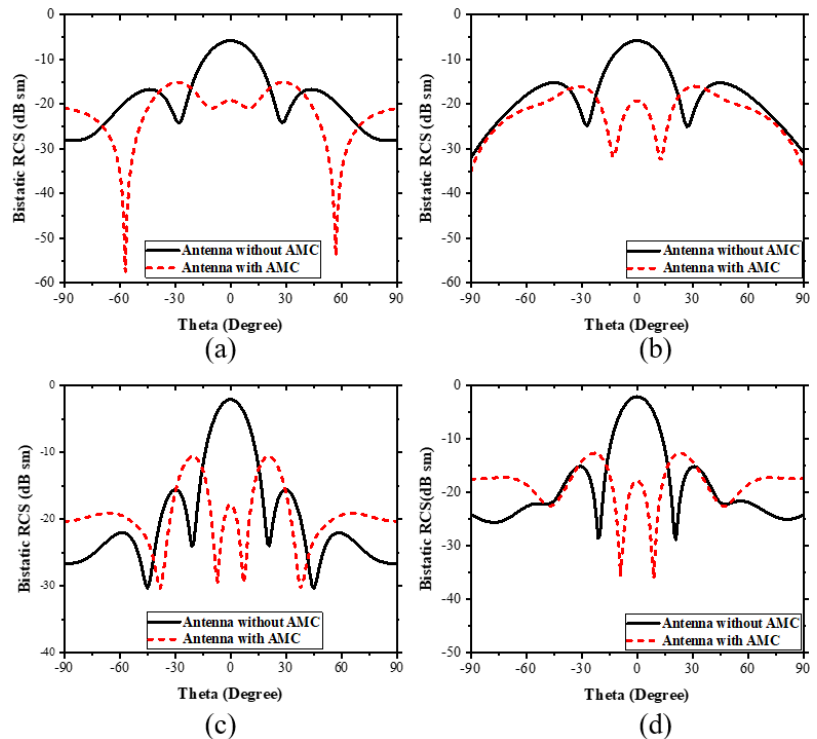
Figure 11. 2-D Bistatic backscattering pattern at 7.6 GHz and 10.4 GHz. ( a ) Pattern 2-D RCS in the xoz plane at 7.6 GHz. ( b ) Pattern 2-D RCS in the yoz plane at 7.6 GHz. ( c ) Pattern 2-D RCS in an xoz plane at 10.4 GHz. ( d ) Pattern 2-D RCS in the yoz plane at 10.4 GHz.